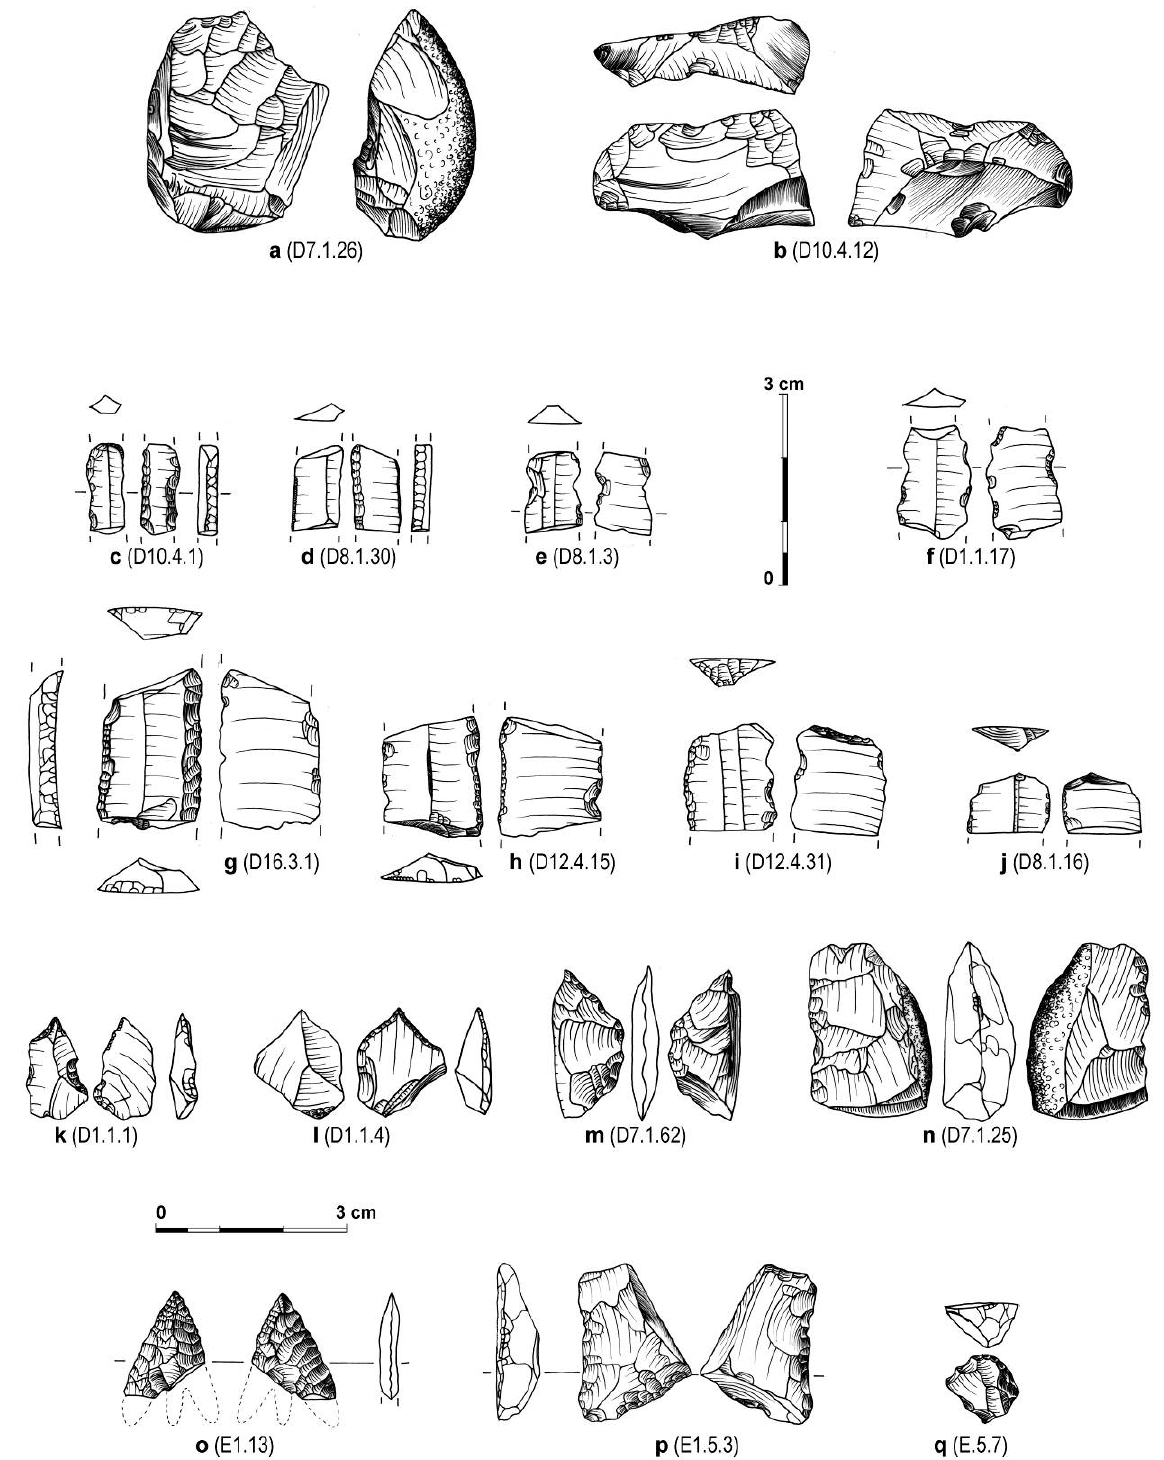
Figure 7. Lithic artefacts from KS D (a-n) and KS E (o-q): a-b: flake cores; c-d: backed bladelets; e-f: retouched bladelets; g-j: truncated blades; k-l: microborer; m-n, p: bifacial implements; o: arrowhead; q: thumbnail scraper; all obsidian (drawings by C.